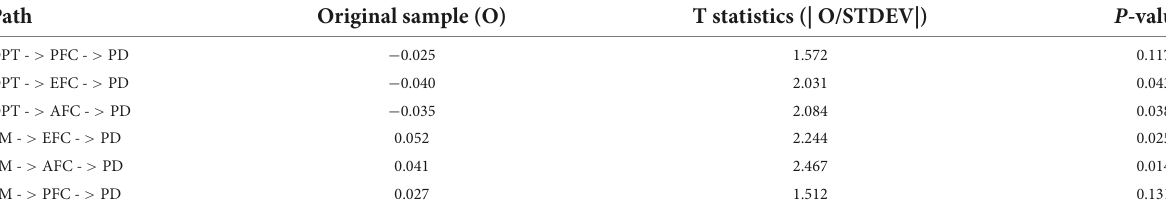
TABLE 6 Specific indirect